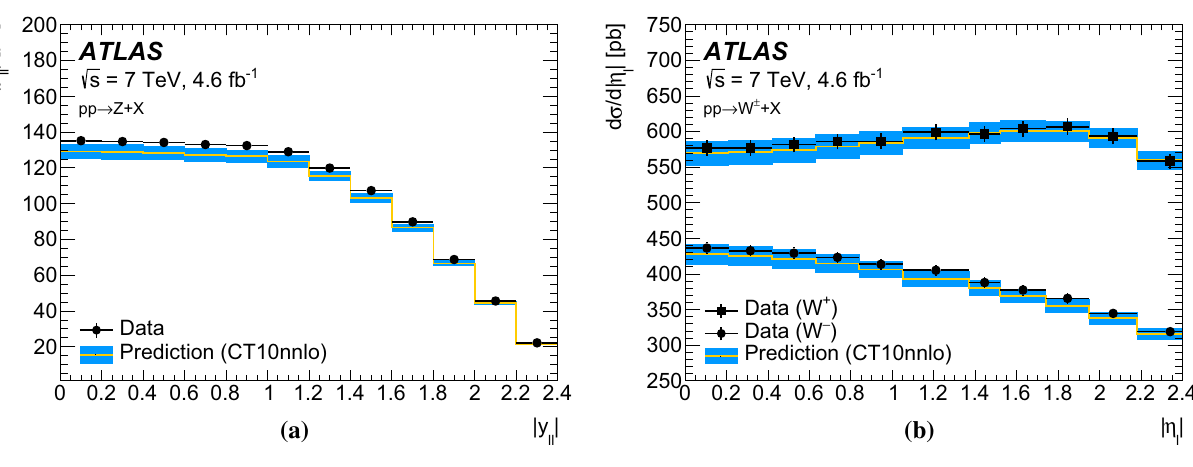
Fig. 3 a Differential Z -boson cross section as a function of boson tions, corrected to NNLO using DYNNLO with the CT10nnlo PDF rapidity, and b differential W + and W − cross sections as a function of set. The error bars show the total experimental uncertainties, including √ s = 7 TeV [41]. The mea- charged decay-lepton pseudorapidity at luminosity uncertainty, and the bands show the PDF uncertainties of sured cross sections are compared to the Powheg+Pythia 8 predic- the